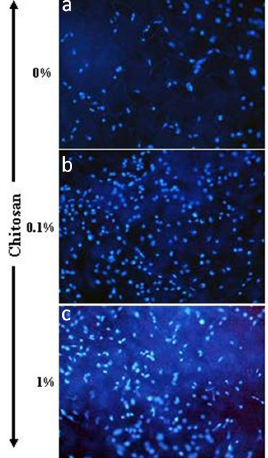
Figure 7. Chondrocyte adhesion on chitosan ‐ coated collagen membranes. Cells were seeded and cultured for 24 h. The cells were then stained with Hoechst dye, observed under an ultraviolet epifluorescence microscope, and photographed. Photographs (200× magnification) are representative of six separate experiments. ( a ) Collagen membrane alone; ( b ) 0.1% chitosan coated collagen membrane; ( c ) 1% chitosan ‐ coated collagen membrane.